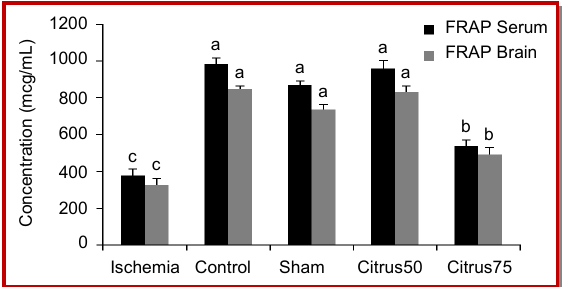
Figure 4: Comparison of anti-oxidant capacity of the serum and brain, similar letters represent no significant difference and dissimilar letters represent significant difference (p<0.05) (Citrus75 and Citrus50: treated with 75 and 50 mg/kg of essential oil, respectively)